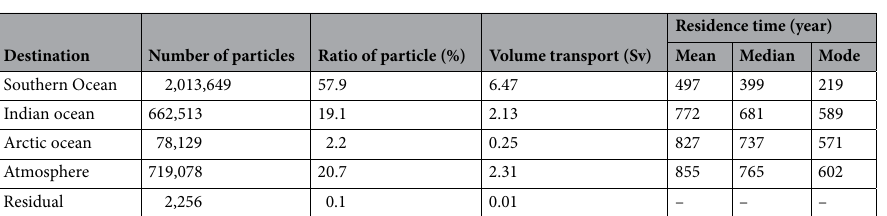
Destination Number of particles Ratio of particle (%) Volume transport